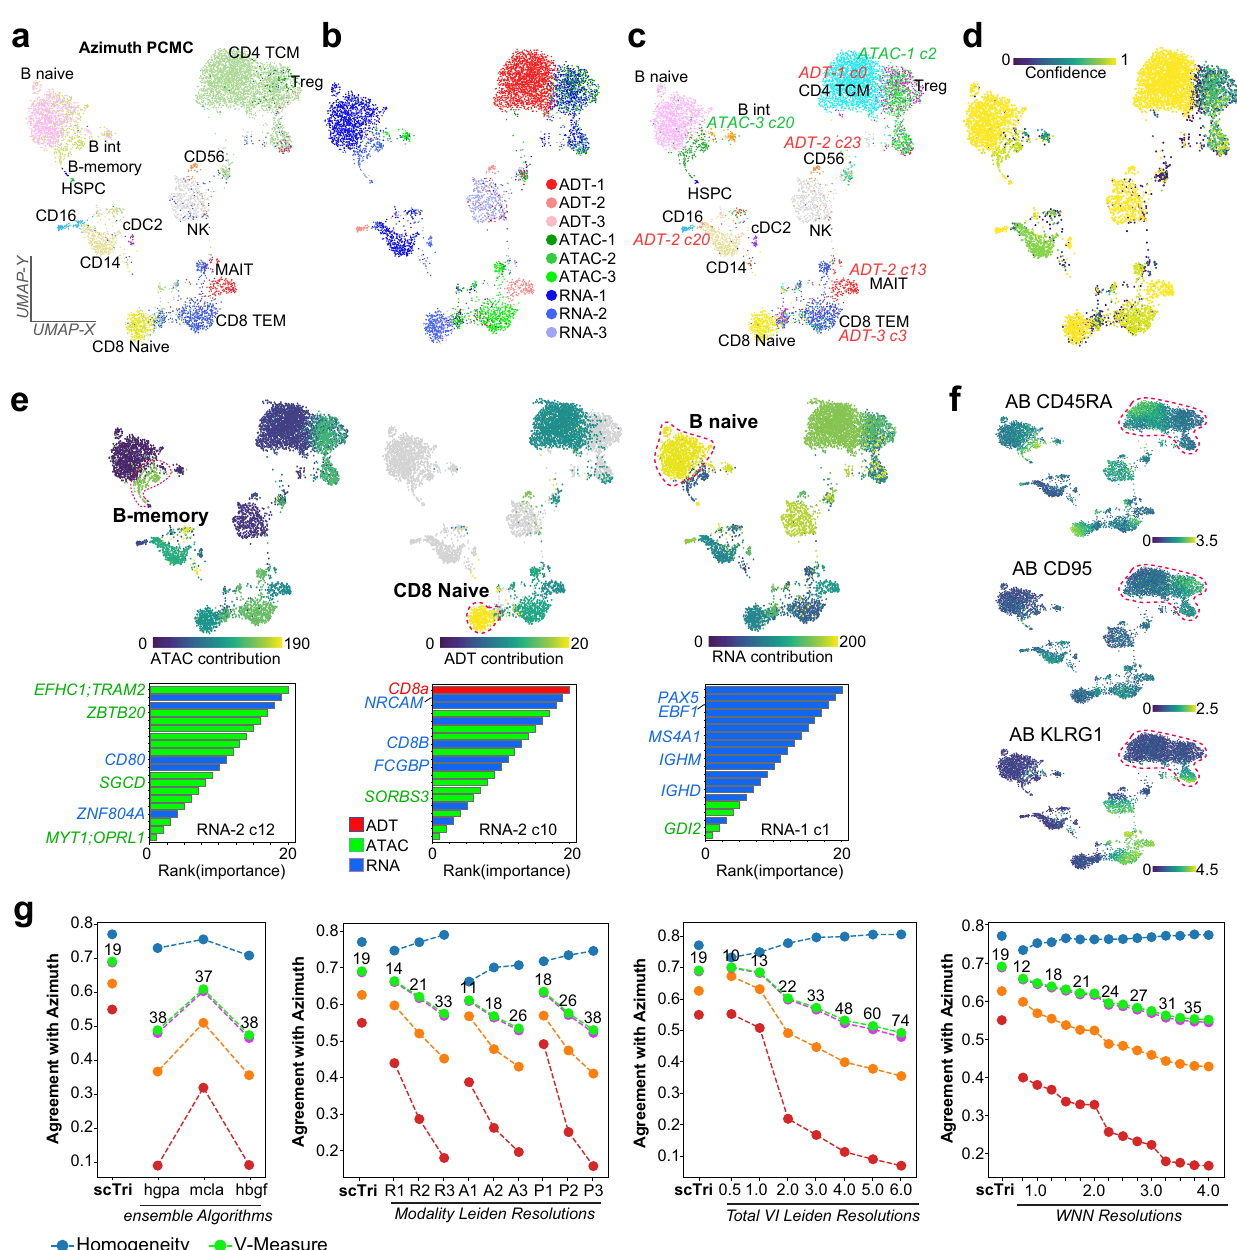
Fig. 3 | scTriangulate identi fi es discrete modality-speci fi c populations with improved performance over alternative methods. a Supervised assignments from prior CITE-Seq cluster PBMC predictions (Azimuth). b Integration of nine independently obtained clustering predictions from tri-modal GEX+ADT+ATAC (TEA-Seq) in donor PBMCs. Each color indicates a distinct modality-speci fi c clus- teringresolution(1-3),withthewinningscTriangulateclustersshown(UMAPbased on ADTs). c Clusters speci fi cally derived from ADT or ATAC clusterresolutions are labeled in the plot. d Con fi dence of each scTriangulate-de fi ned cluster. e The selective contribution of each indicated modality is overlaid on the UMAP (top panels), based on the frequency of associated features among the top 20 markers of each fi nal cluster (scTriangulate visualization). In the bottom panel, the top- rankedfeatures forrepresentative clustersareindicated bytheir modality (color),